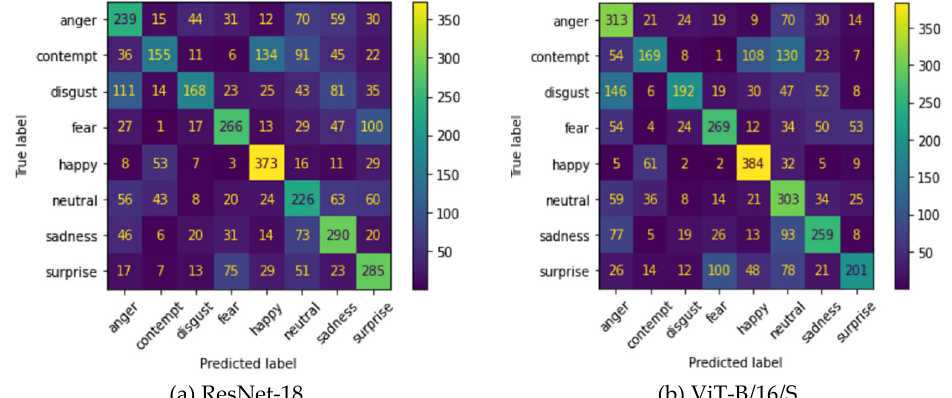
Figure 12. Tables of precision, recall, and F1-score for each class.